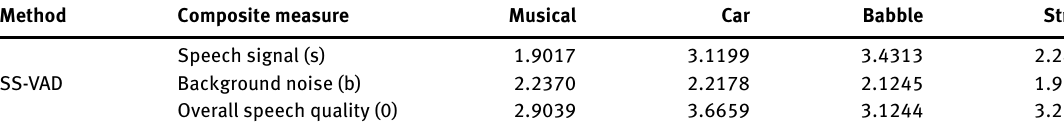
Table 5: Performance Evaluation of SS-VAD Method Using Composite Measure for Kannada Database.